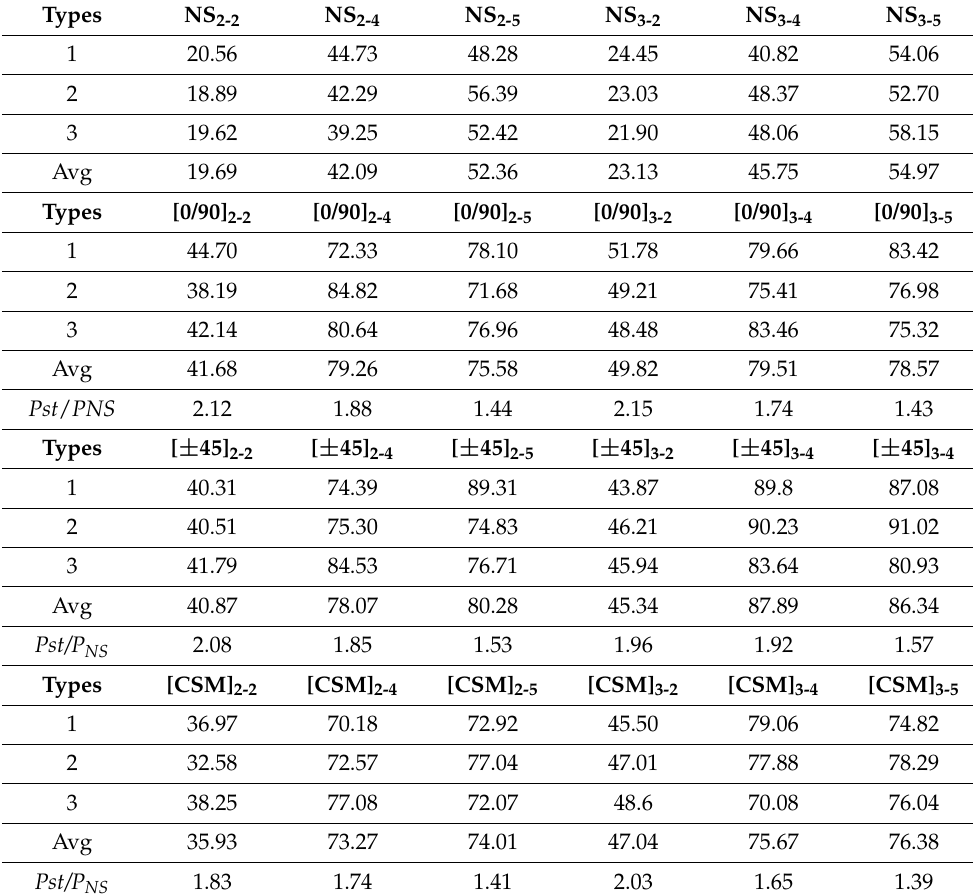
Table 5. The ultimate loads of PGFRP connections and the strengthening effects of GFSs (unit: